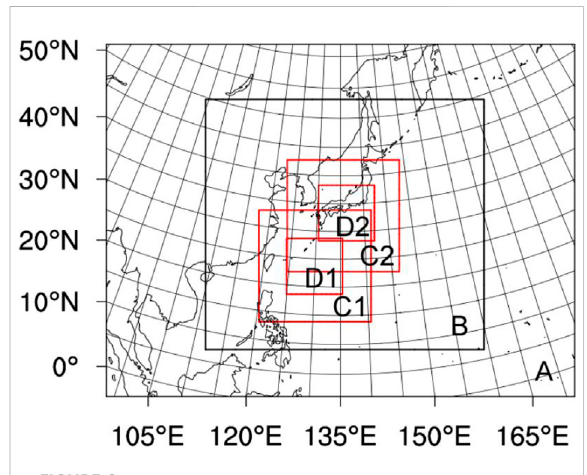
FIGURE 2 Model domain con fi guration. Domains A, B, C and D have horizontal resolutions of 54, 18, 6 and 2 km, respectively. Domain C and D are designed to follow the movement of the storm, with C1 (D1) and C2 (D2) denoting the initial and fi nal position of the domain,